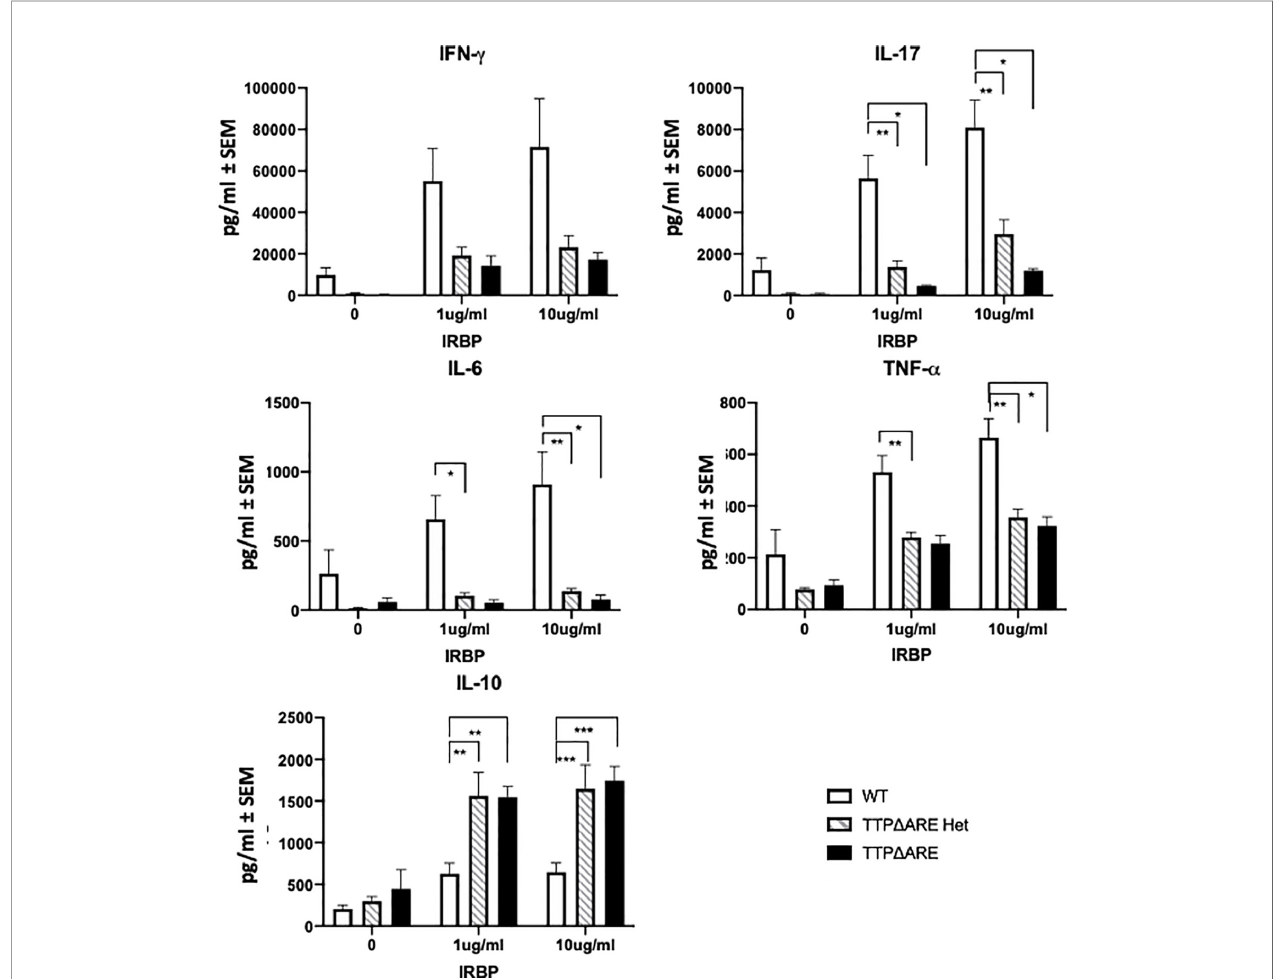
FIGURE 4 | Cytokine production by lymphocytes from TTP D ARE homozygous and heterozygous mice and their WT controls. Lymph node cells from the immunized mice of the three genotypes were incubated with IRBP at 1 or 10 µg/ml, and their supernatants were collected after 2 days (or 3 days for IL-10), and tested for the indicated cytokines, t-test was used for statistical comparisons: *p < 0.05; **p < 0.01; ***p <